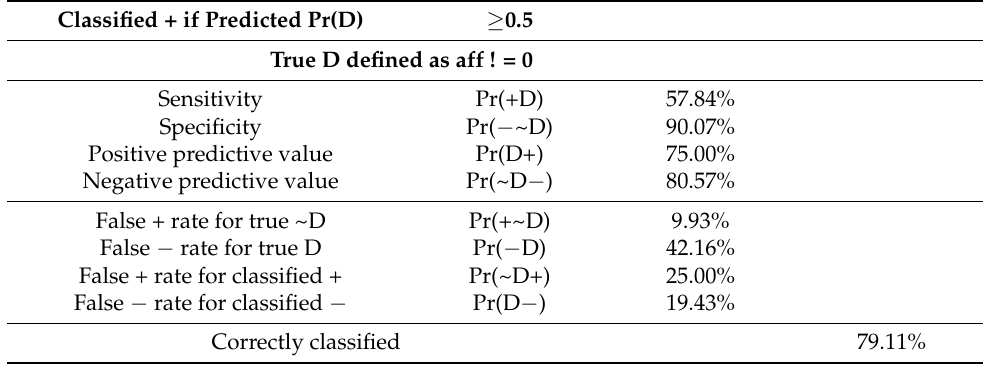
Table A10. Test of reliability of the logit model in Table 2 (dependent variable: informal employment).